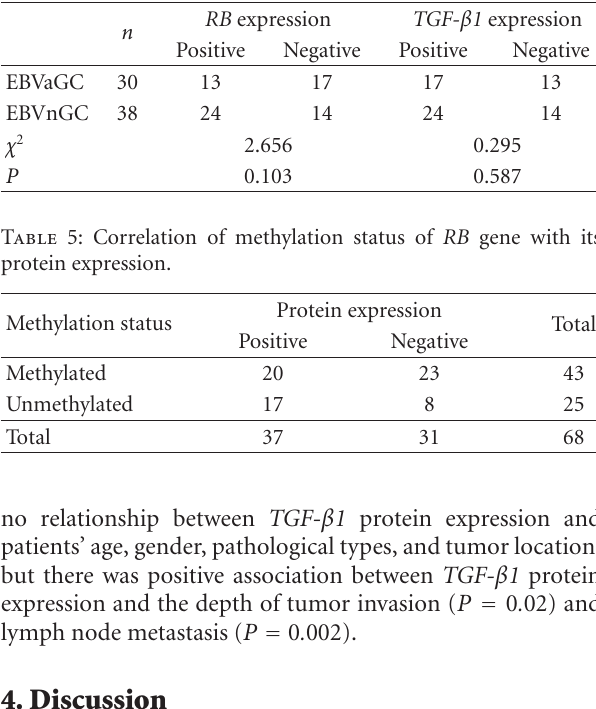
Table 4: Comparisons of the expression of RB and TGF- β 1 between EBVaGC and EBVnGC.